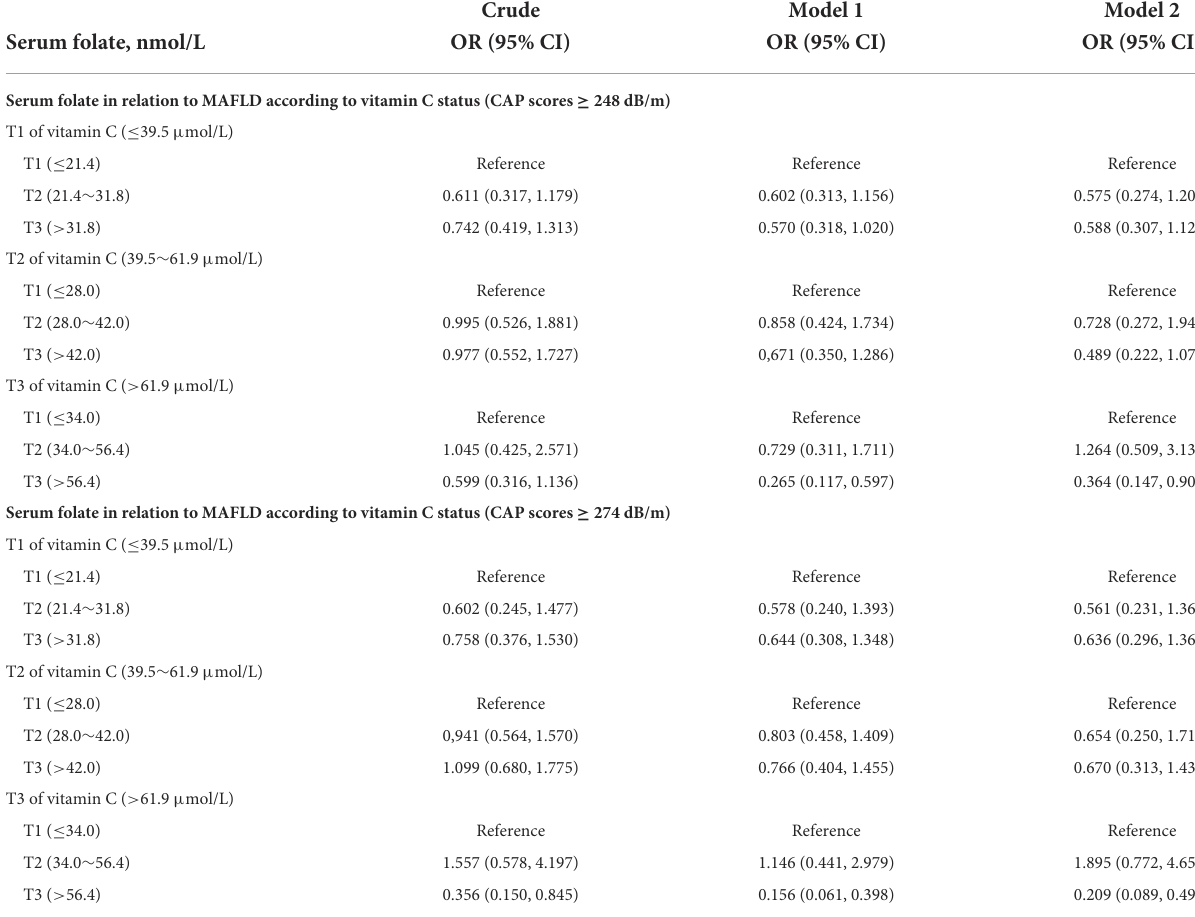
and liver fibrosis (Supplementary Table